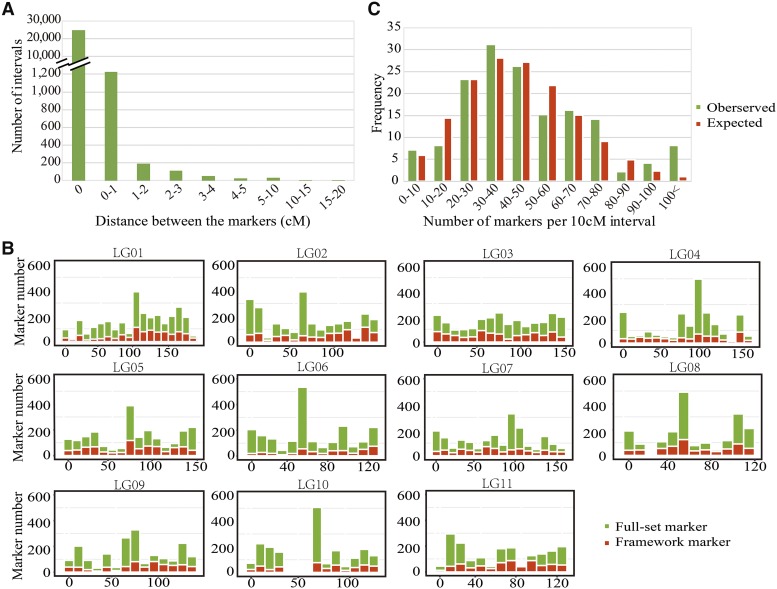
Spatial distribution of marker density along each LG. A) Distribution of the map distance between two adjacent mapped markers. B) distribution of framework and full-set markers along 10 cM sliding windows of each LG. C) Poisson distribution of the observed and expected frequencies of markers distributed at 10 cM interval.